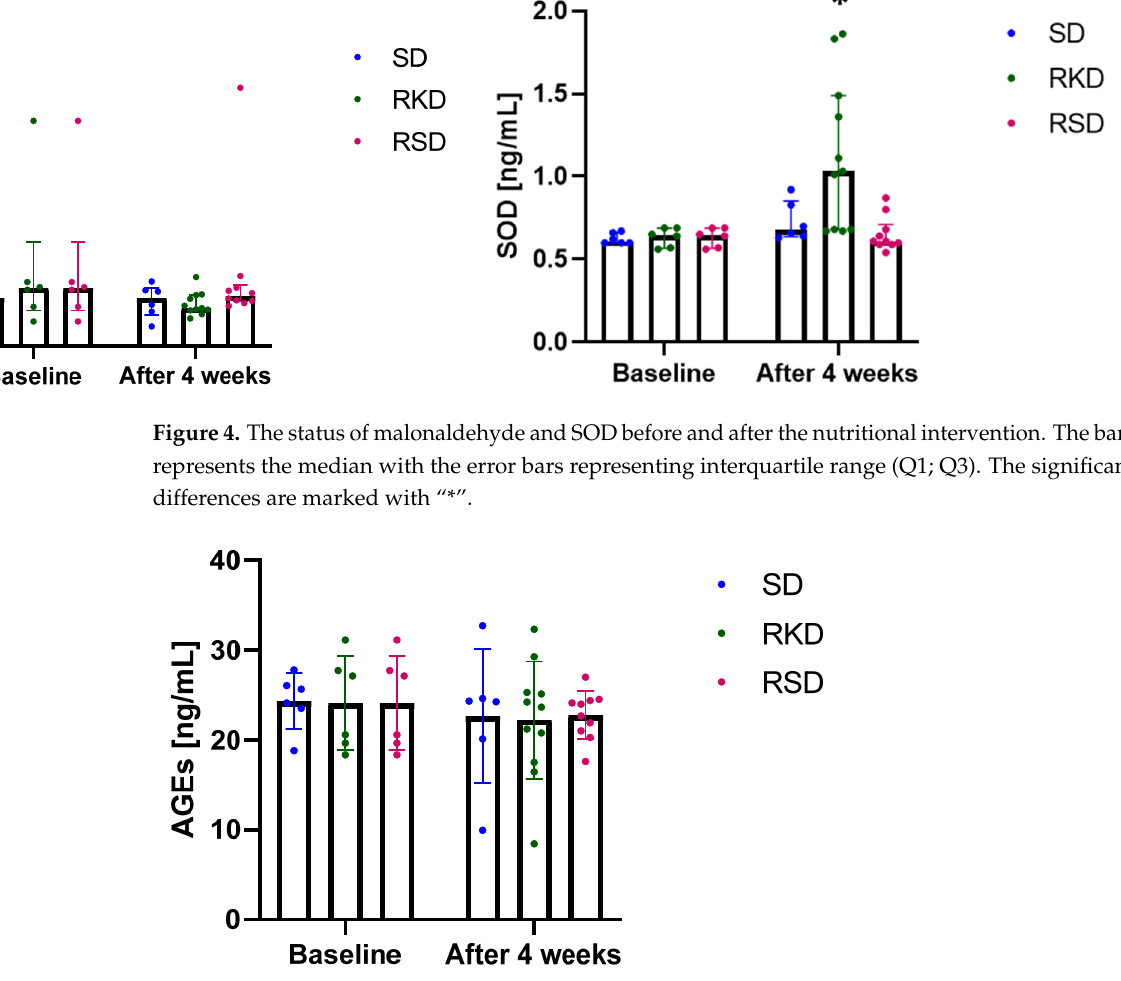
Figure 5. The plasma concentration of advanced glycation end-products (AGEs) before and after the intervention. The bars represents the mean with the error bars representing standard deviation.